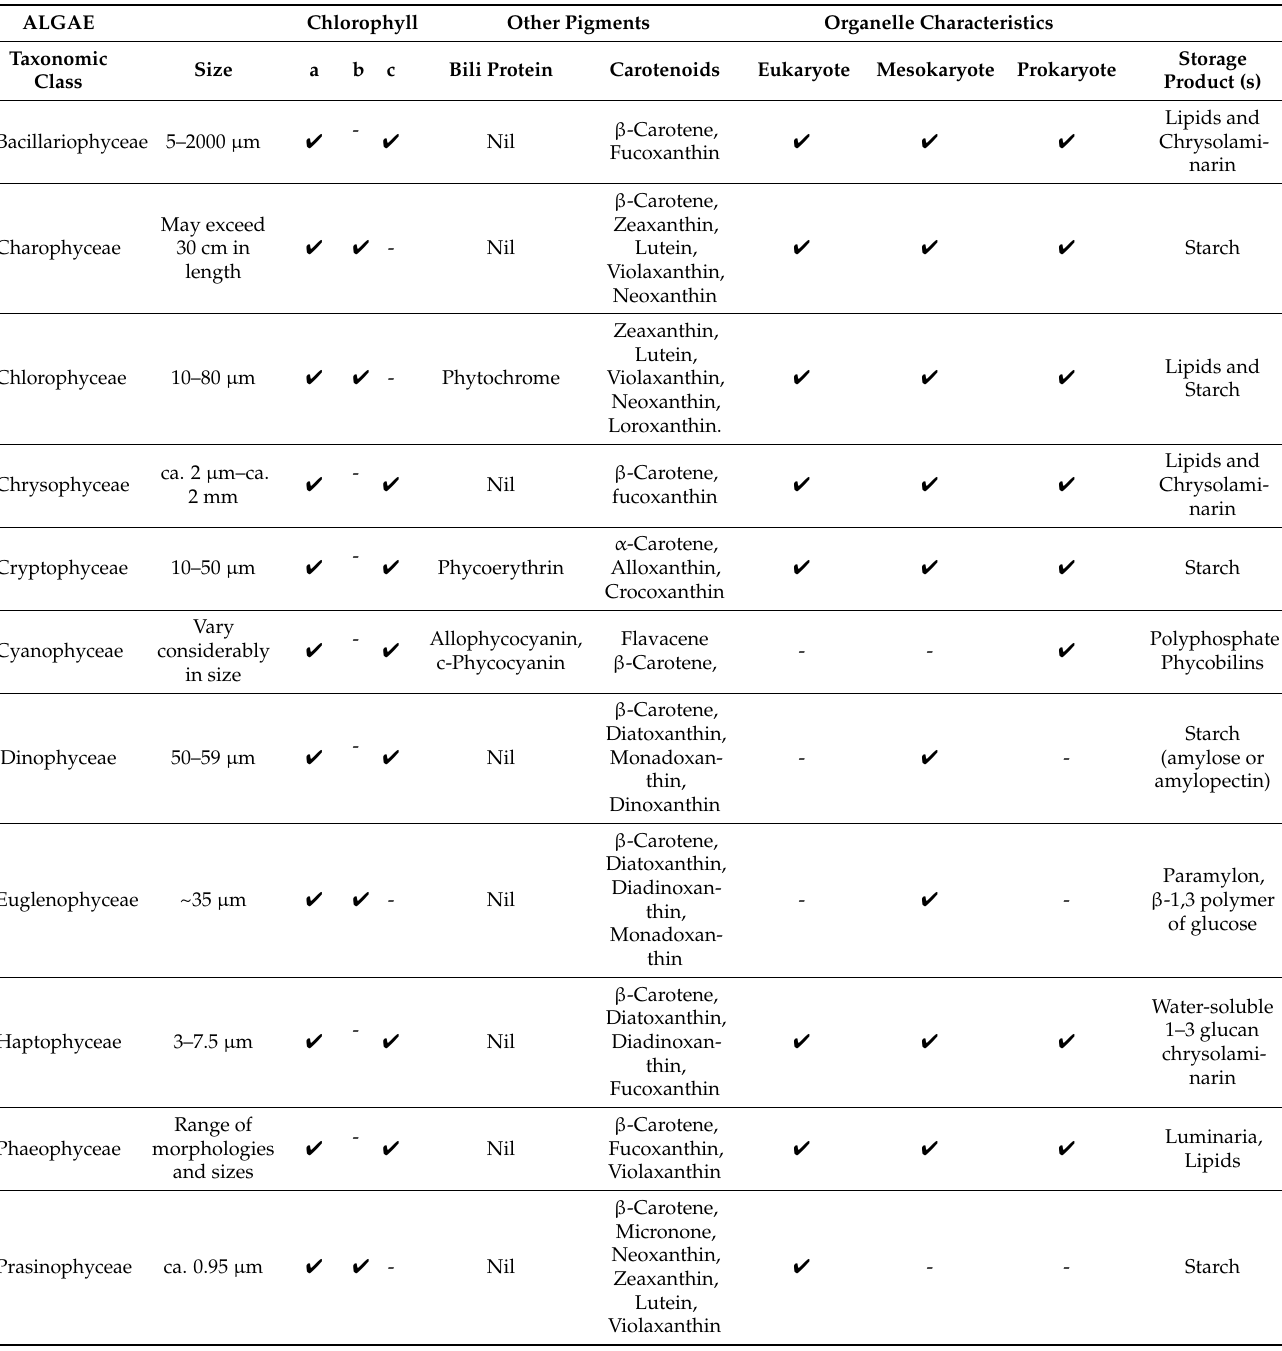
Table 1. Characteristics of a few algal taxonomic